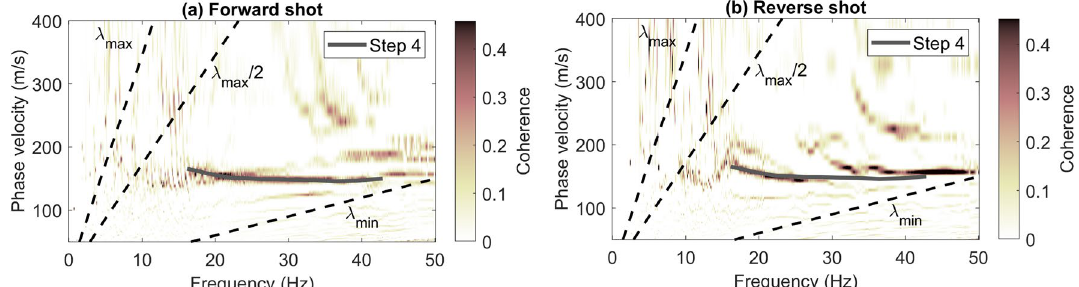
Fig. 4 Active source MAS; high-resolution MASW images computed with the deblurring method (Mikesell et al. 2017). The Step 4 active-source dispersion curve was picked using the area, where forward and reverse shot record MASW images appeared to